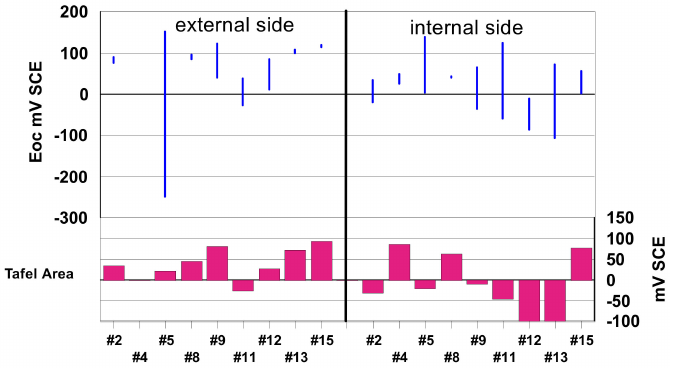
Figure 22. Summary of